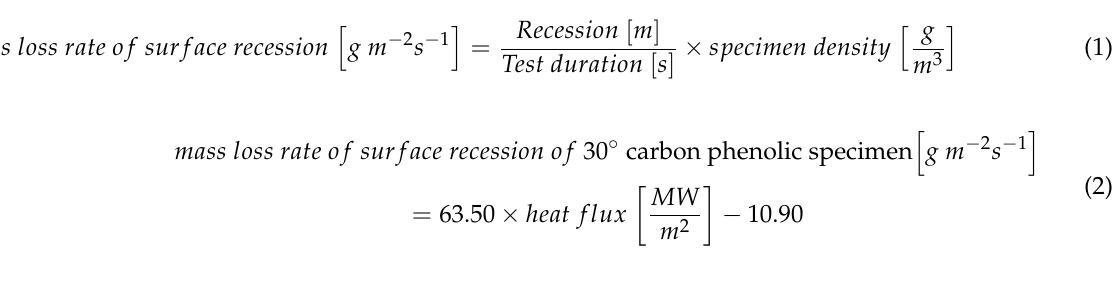
Table 2. Specimen mass loss rate and recession rate.